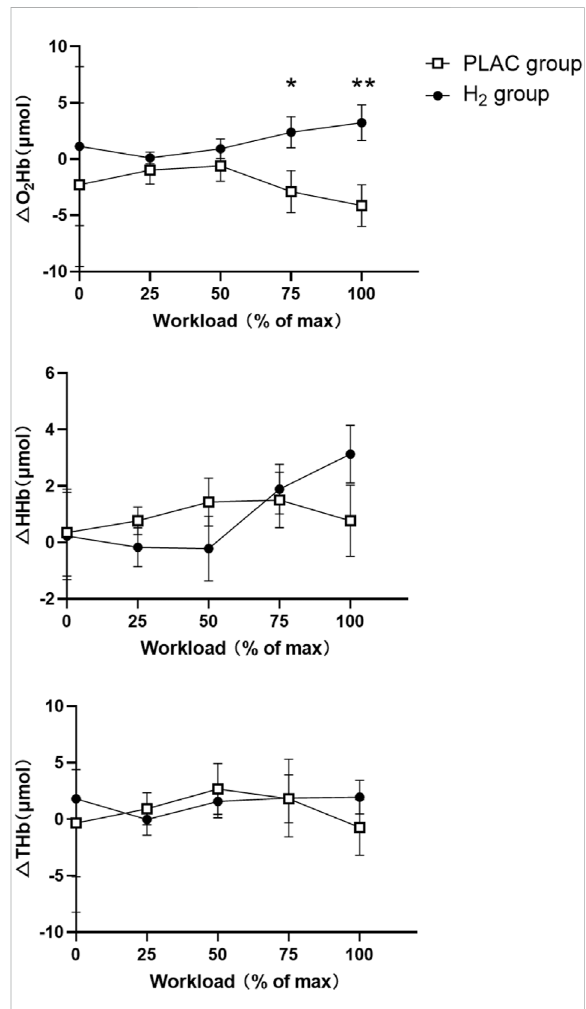
FIGURE 2 PFC activation during thecycling exercise inthePLAC and H 2 groups. Note: * Signi fi cant differences compared with the PLAC group under the same workload, * = p < 0.05, ** = p < 0.01. Abbreviations: O 2 Hb = oxyhemoglobin; HHb = deoxyhemoglobin; THb = total